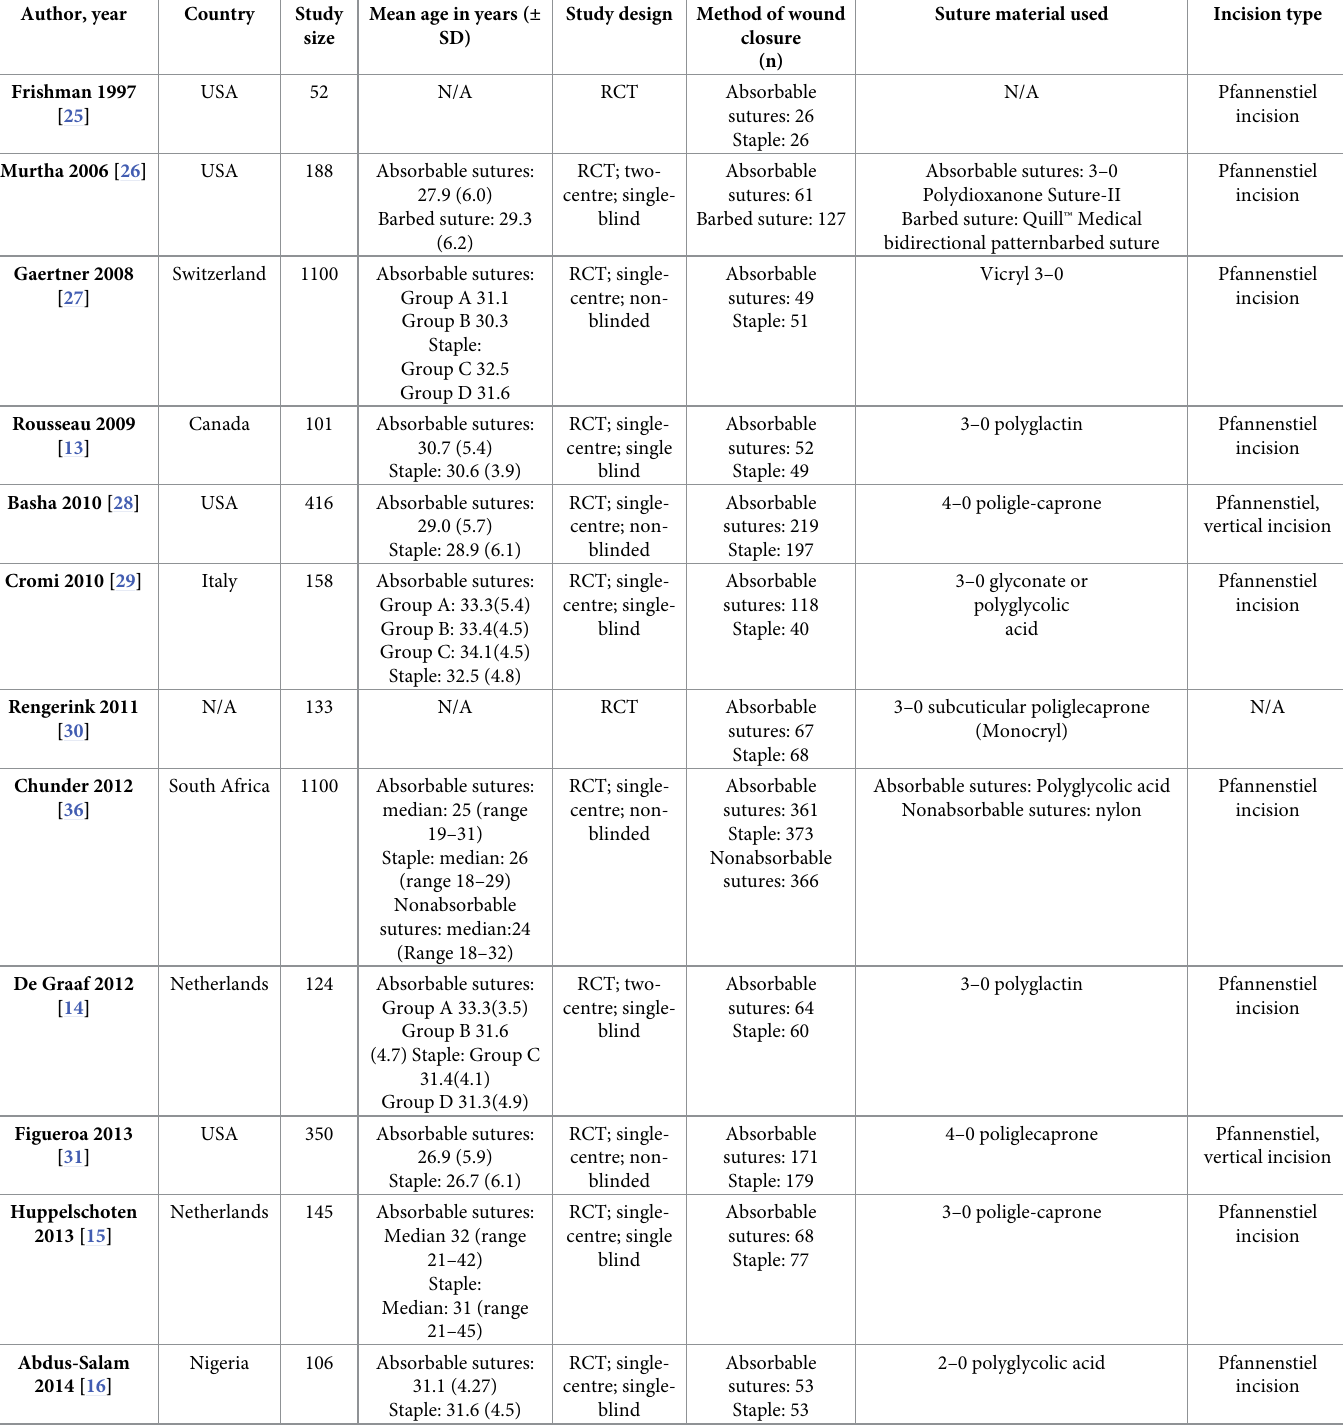
Table 1. Characteristics of the included